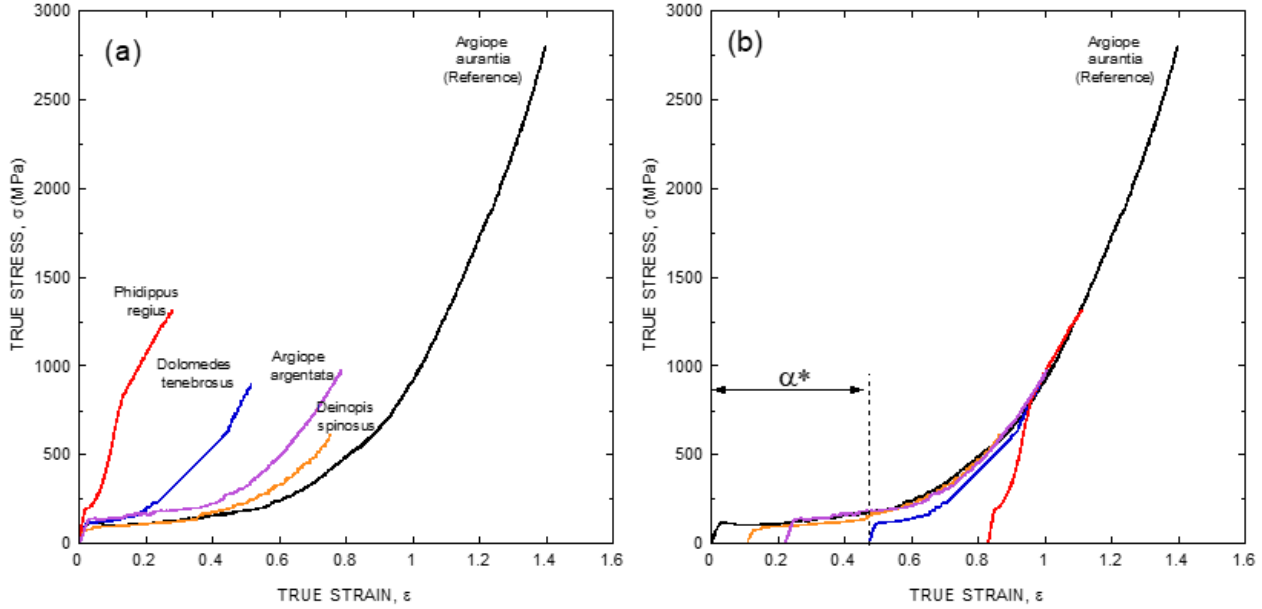
Figure 2. ( a ) Comparison of true stress-true strain curves of fibers spun by different spiders species of the Entelegynae suborder after being subjected to maximum supercontraction (MS curves). ( b ) Definition of the α * parameter by displacing the true stress-true strain curves of the maximum supercontracted fibers along the true strain axis (X-axis) so that it concurs with the Argiope aurantia MS curve used as reference at high values of true strain. The experimental details may be found in the corresponding references by the authors cited in the main text.